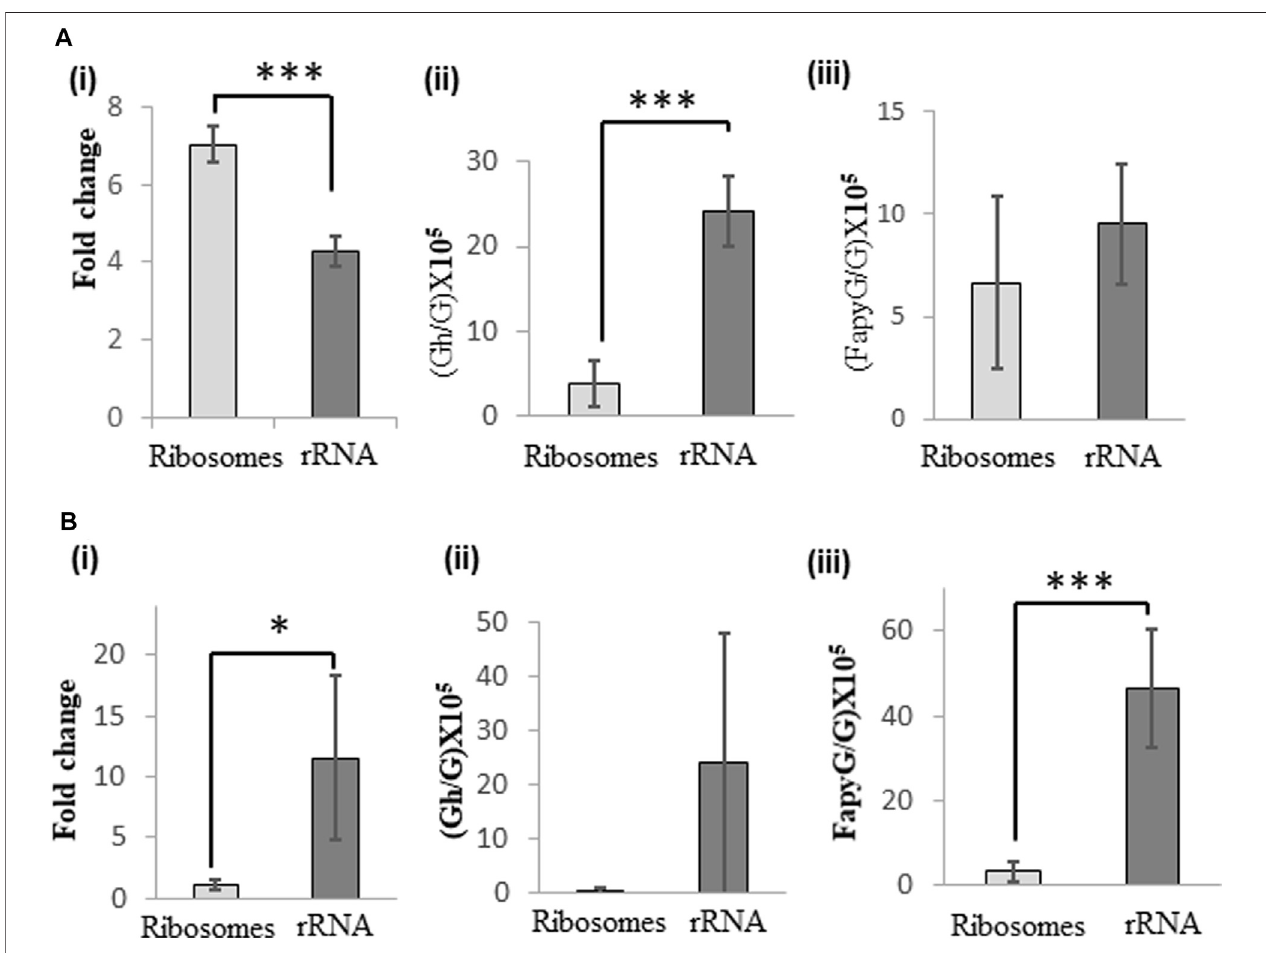
FIGURE 1 | Changes in levels of guanosine oxidation products of ribosomal RNA following exposure of ribosomes and rRNA to oxidative stress. (A) UVA-induced changes in levels of (i) 8-oxo-G, (ii) Gh, and (iii) FapyG in rRNA and ribosomes. (B) Fenton-reaction induced changes in levels of (i) 8-oxo-G, (ii) Gh and (iii) FapyG upon exposure of rRNA or ribosomes. To account for the oxidation products detected in unexposed samples, Fold Change between exposed/unexposed samples was computedfollowingnormalizationofthequantumofeachsignalagainstinternalstandard5 ′ bromo-2 ′ deoxycytidine.GhandFapyGlevelsareexpressedasper10 5 G, as they were not detected in unexposed samples. Data are shown as the mean of fi ve independent samples ± SD. Statistical differences were determined using unpaired two-tailed t -test (* p < 0.05; *** p < 0.001).